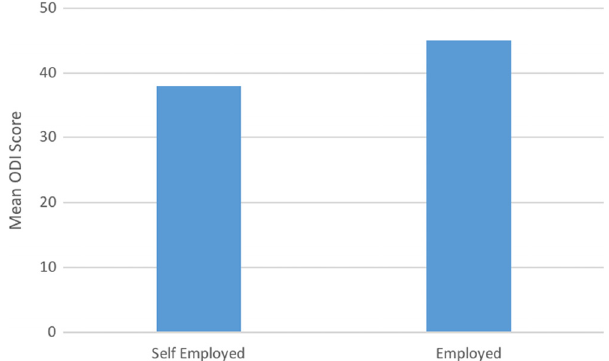
Figure 4. Graphical representation of the mean ODI score of those that are self-employed compared to those in employment.